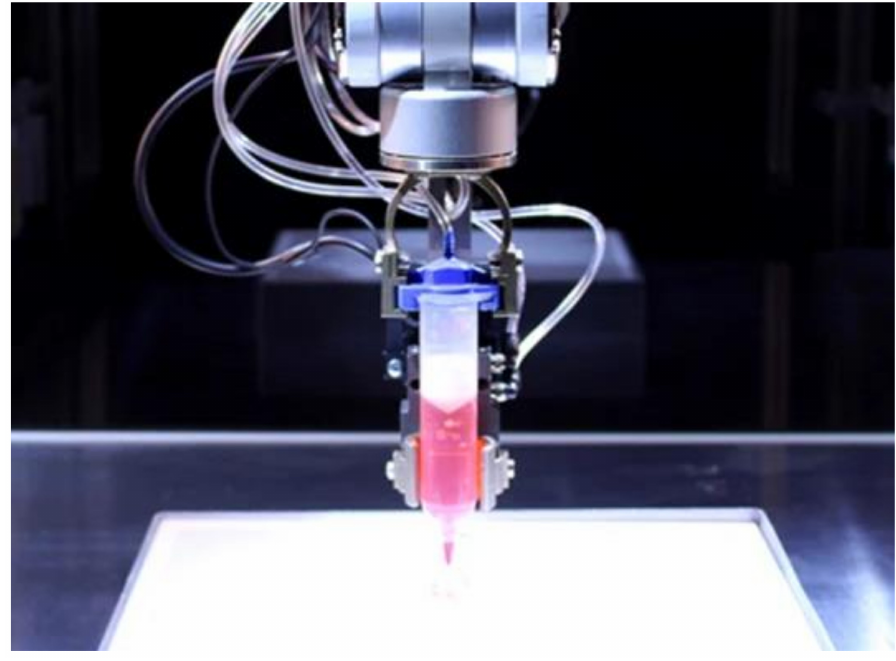
Figure 5. Inkjet 3D bio-printer